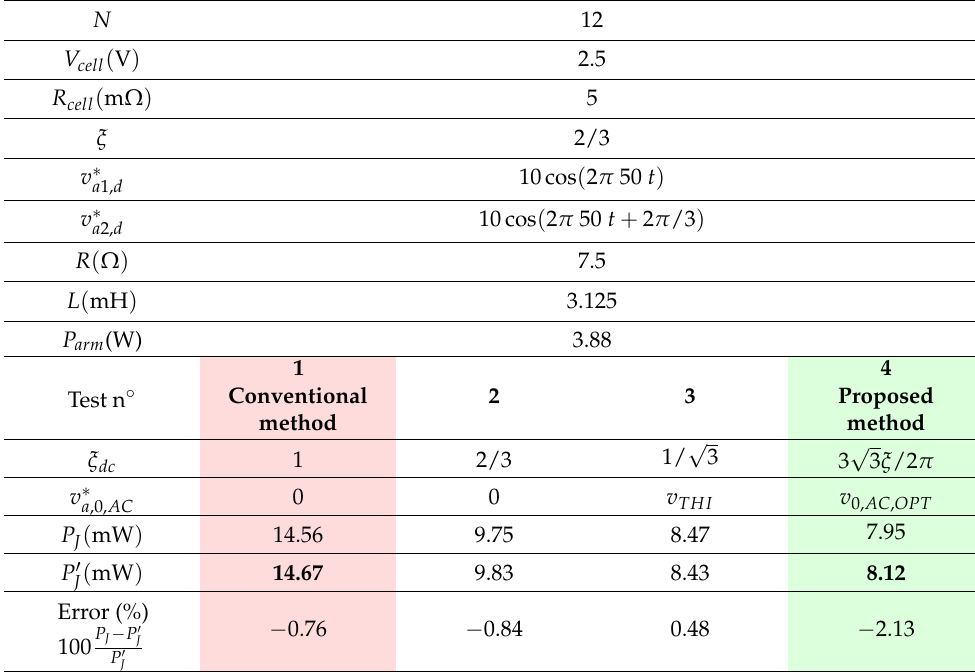
Table 1. Details of the performed tests and